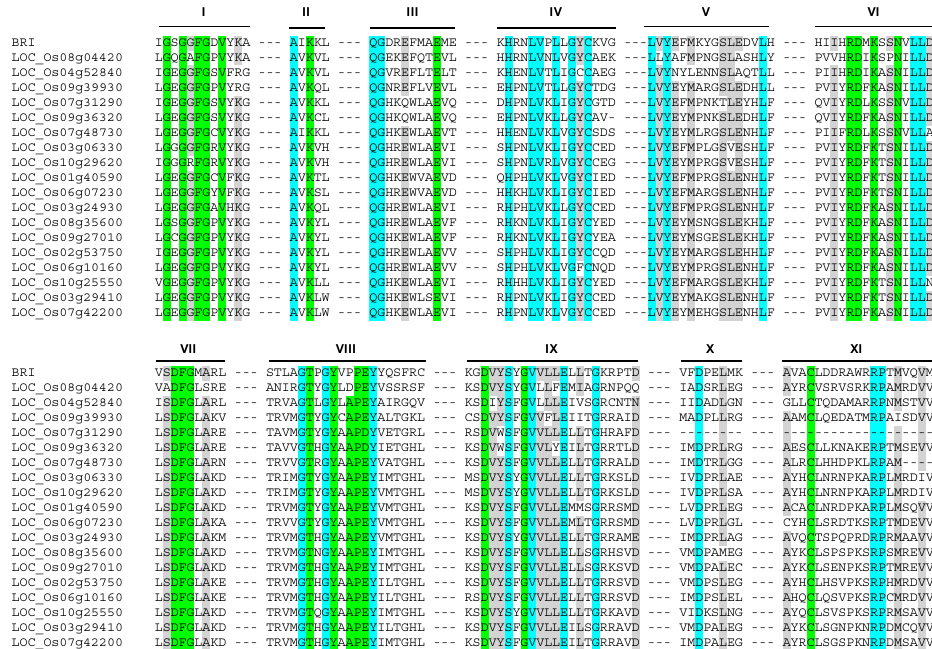
Figure 2. Multiple sequence alignment of rice PTK proteins with BRI (BRASSINOSTEROID INSENSITIVE 1). Roman numbers denote sub-domains of protein kinase. The codes for shades are: Green, conserved and essential for kinase activity; Cyan, conserved; Grey, >80% conservation with BRI.